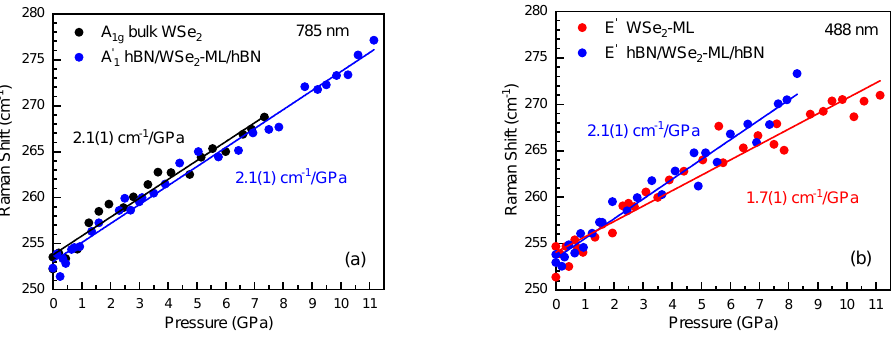
Figure 6: Comparison of the pressure dependence of first-order Raman active modes: (a) The A 1 g mode bulk WSe 2 and the A’ 1 of the hBN/WSe 2 -ML/hBN heterostructure measured with 785 nm excitation and (b) the E’ mode of the bare WSe 2 ML and hBN/WSe 2 -ML/hBN heterostructure. Lines represent least-squares fits to the data points and numbers in parentheses represent error